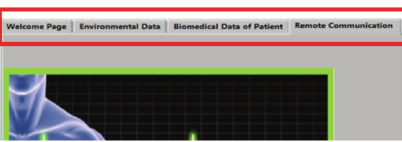
Figure 12: MCT interface in LabVIEW—welcome page [14].